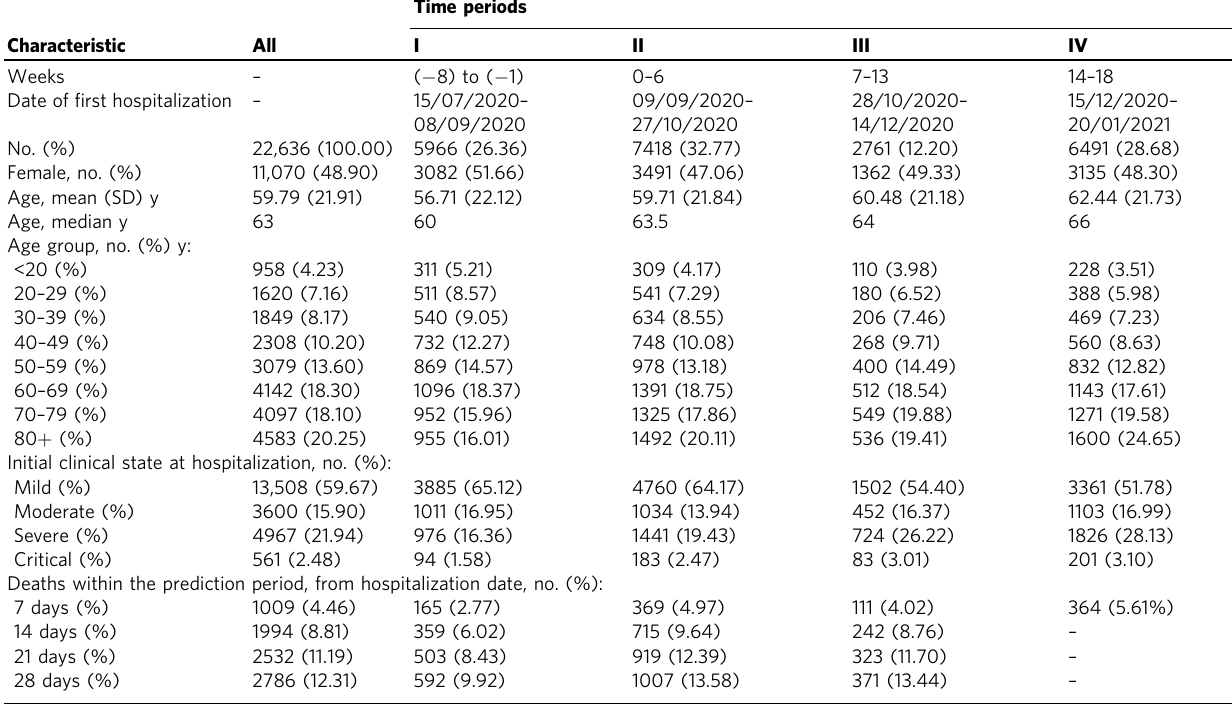
Table 1 Cohort characteristics.